Question: What does this figure show? Answer in one sentence.
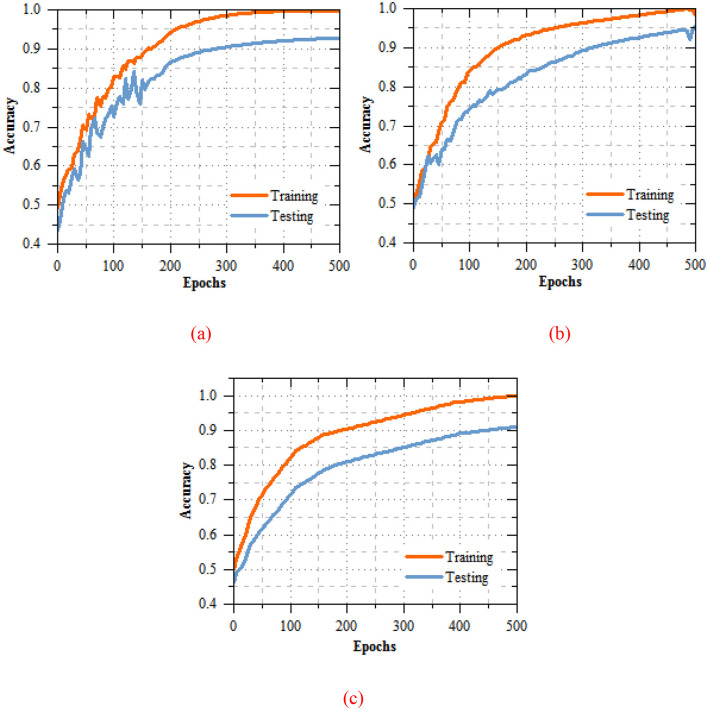
Answer: Training and testing accuracy of LCNN using (a) MIAS, (b) BreakHis, and (c) multimodal datasets.